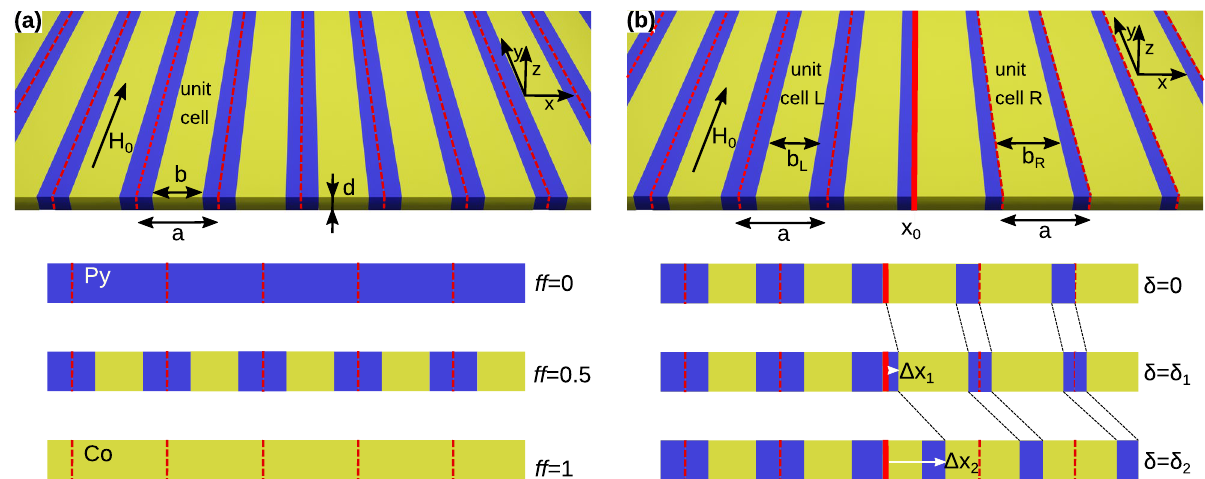
Figure 1. ( a ) The geometry of the one-dimensional magnonic crystal. Red dashed lines mark the edges of centrosymmetric unit cells of the size a (lattice constant). Yellow and blue colors distinguish the strips made b , respectively. The strips are thin d a , and the magnetic field H 0 is of Co and Py of the width: b and a − ≪ applied along the strips (static demagnetizing effects are absent). In our studies, we changed the width of both strips, keeping the lattice constant fixed (see the inset below a ). By sweeping the bulk parameter (i.e., the filling b / a in the range [0, 1 ) , we can tune the SW spectrum between the limits corresponding to the fraction) ff = 0 ) and Co ( ff 1 ). (b) Two semi-infinite magnonic crystals differing in filling uniform layer of Py ( ff = = ff R ), interfaced at the edges of units cells (solid red line). For the magnonic crystal on the left fractions ( ff L = (right) side, we chose a centrosymmetric (non-centrosymmetric) unit cell. The selection of the unit cell does not affect the spectrum of the infinite magnonic crystal but is important for the formation of interface states. [0, 1 ) , describing the selection (i.e., the shift) of the unit cell, can then be treated � x / a The parameter δ = = as an interface parameter (see the inset below b ). The values δ 1 , δ 2 (and (cid:31) x 1 , (cid:31) x 2 ) correspond to two possible selections of centrosymmetric unit